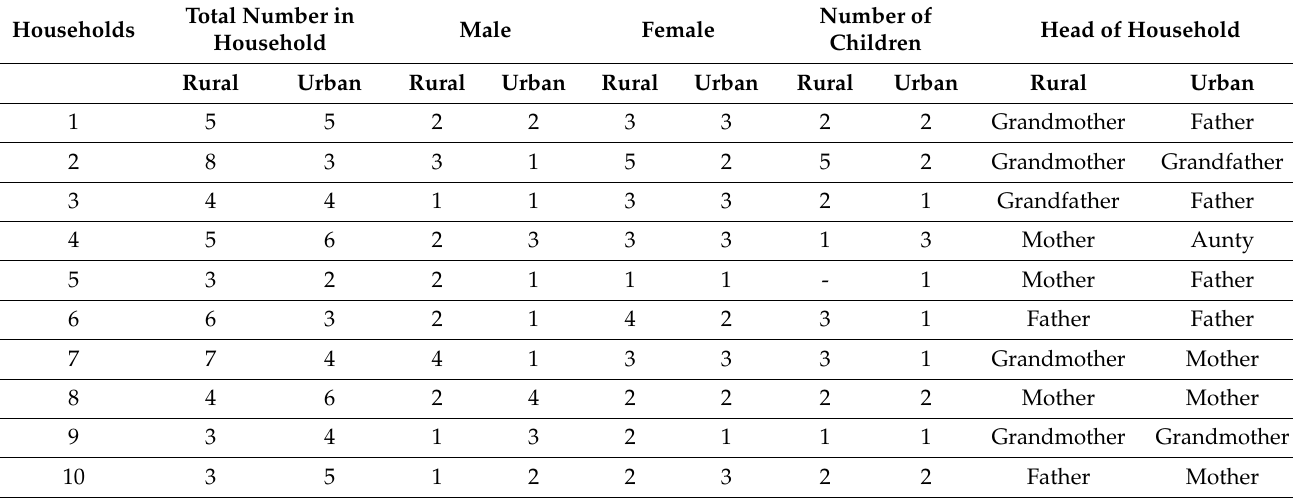
Table 1. Demographic characteristics of the participants in stage